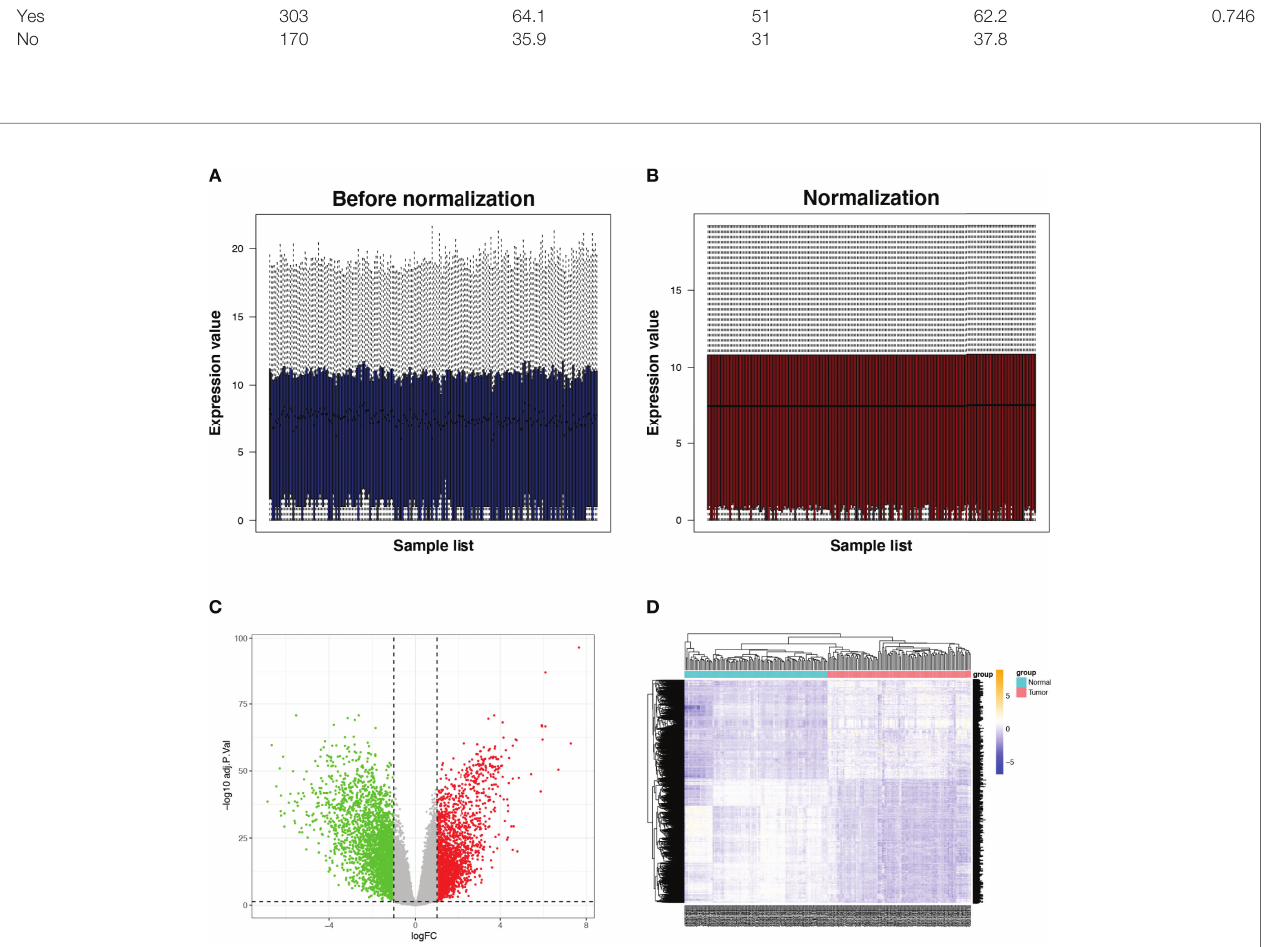
FIGURE 2 | Expression of IRGs in BRCA. (A, B) Comparison before and after standardisation of expression data. (C, D) Volcano and heat maps of DEGs in tumor and normal tissues. Green dots represent genes that are down-regulated, red dots represent genes that are up-regulated and grey dots represent genes that are not signi fi cantly changed. IRG, immune-related gene; DEG, differentially expressed gene.